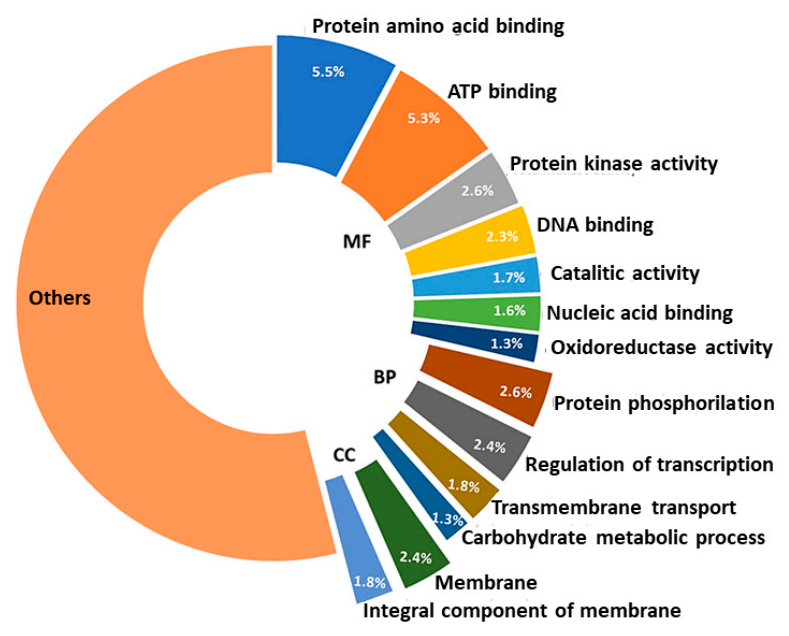
Figure 5. Thirteen main sub-GO categories of genes containing SSRs.